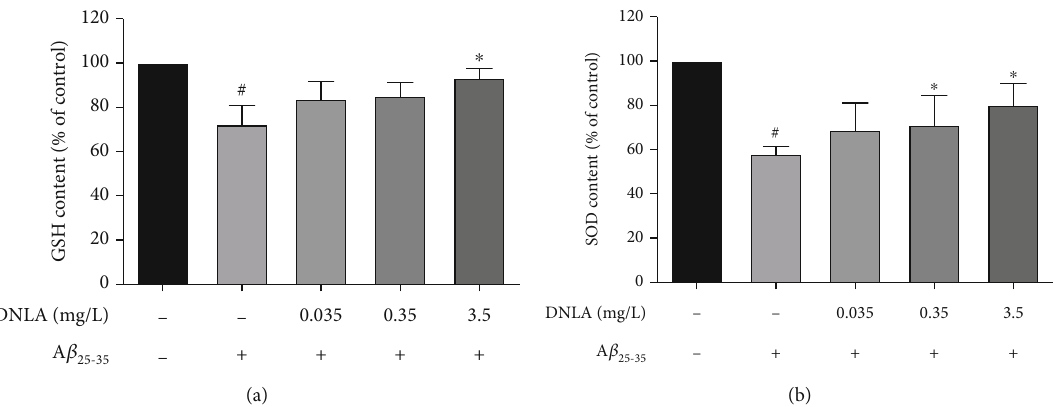
Figure 5: E ff ect of DNLA on the GSH content and SOD activity of PC12 cell damage induced by A β PC12 cells. (b) The intracellular SOD activity in PC12 cells ( n = 3 , (cid:1) x ± s ). Note: # P < 0 : 05 vs. control; ∗ P < 0 : 05 vs.